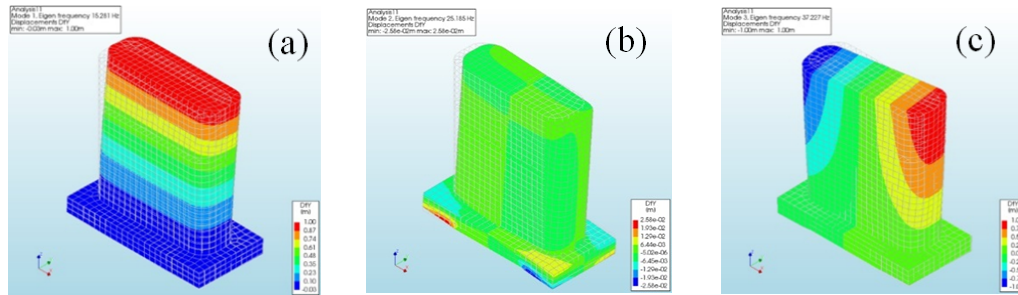
Figure 7. Mode number analysis. ( a ) First mode; ( b ) second mode, and ( c ) third mode.